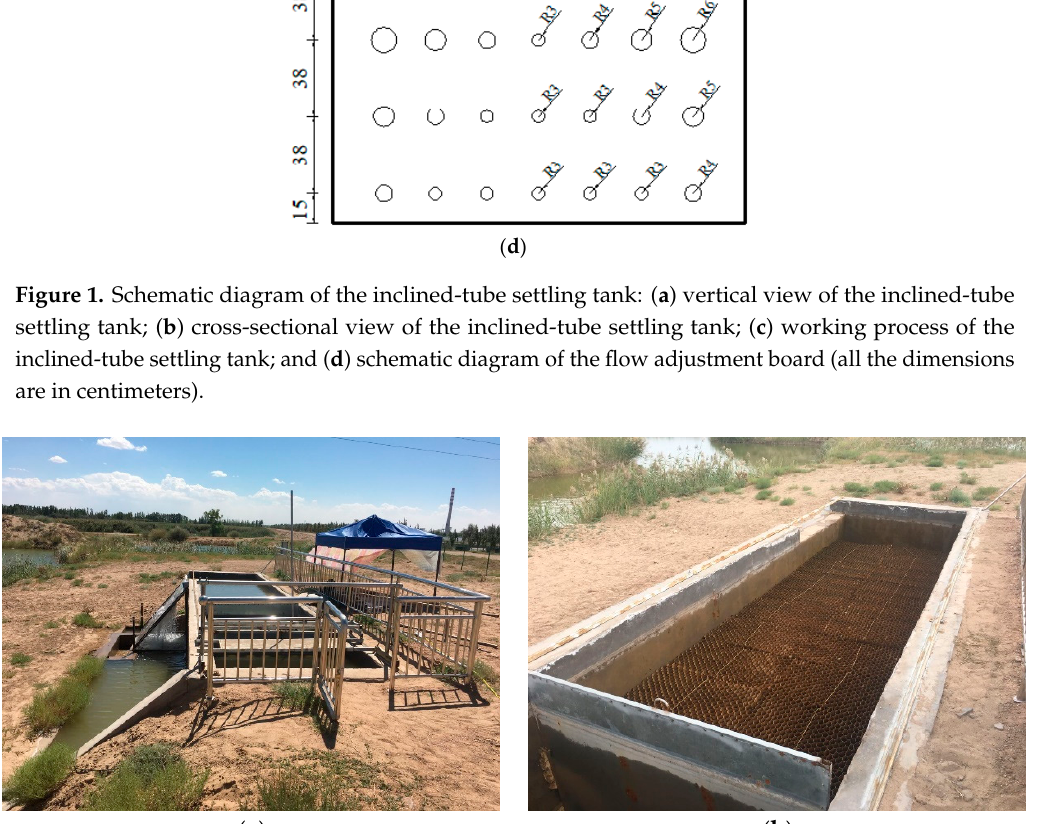
Figure 2. Photographs of the inclined-tube settling tank: ( a ) full view of the inclined-tube settling tank, ( b ) detailed view of inclined tubes.